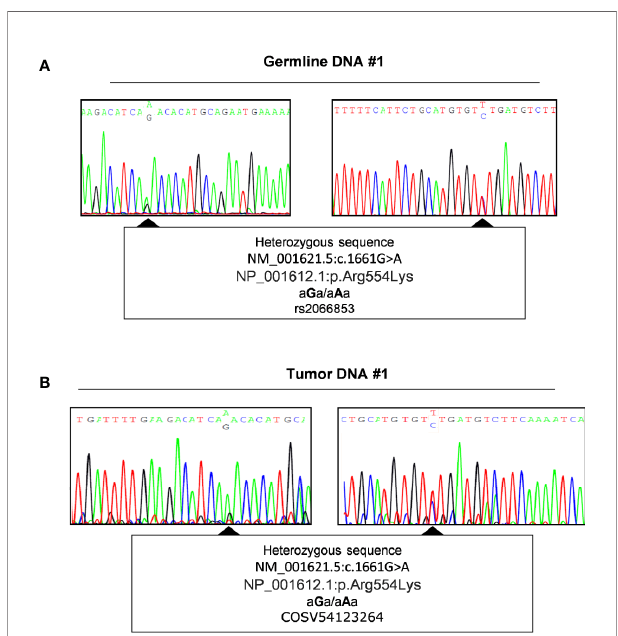
FIGURE 3 | Evaluation of Loss of heterozygosity. Representative sequence analysis of aryl hydrocarbon receptor ( AHR ) exon 10, surrounding region of polymorphism rs2066853, in germline (A) and tumor DNA (B) of the same patient (#1). The polymorphism rs2066853 (c.1661 G>A) or its correspondent genomic mutation ID COSV54123264 are arrowed in germline (A) and tumor DNA (B) , respectively. Left and right panels show sequence analysis performed with forward and reverse primers,